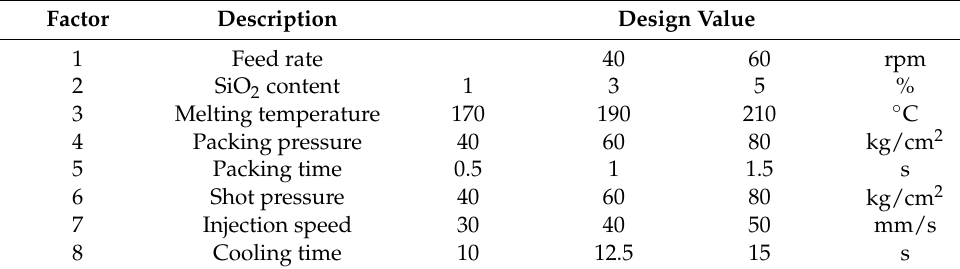
Table 1. Processing parameter